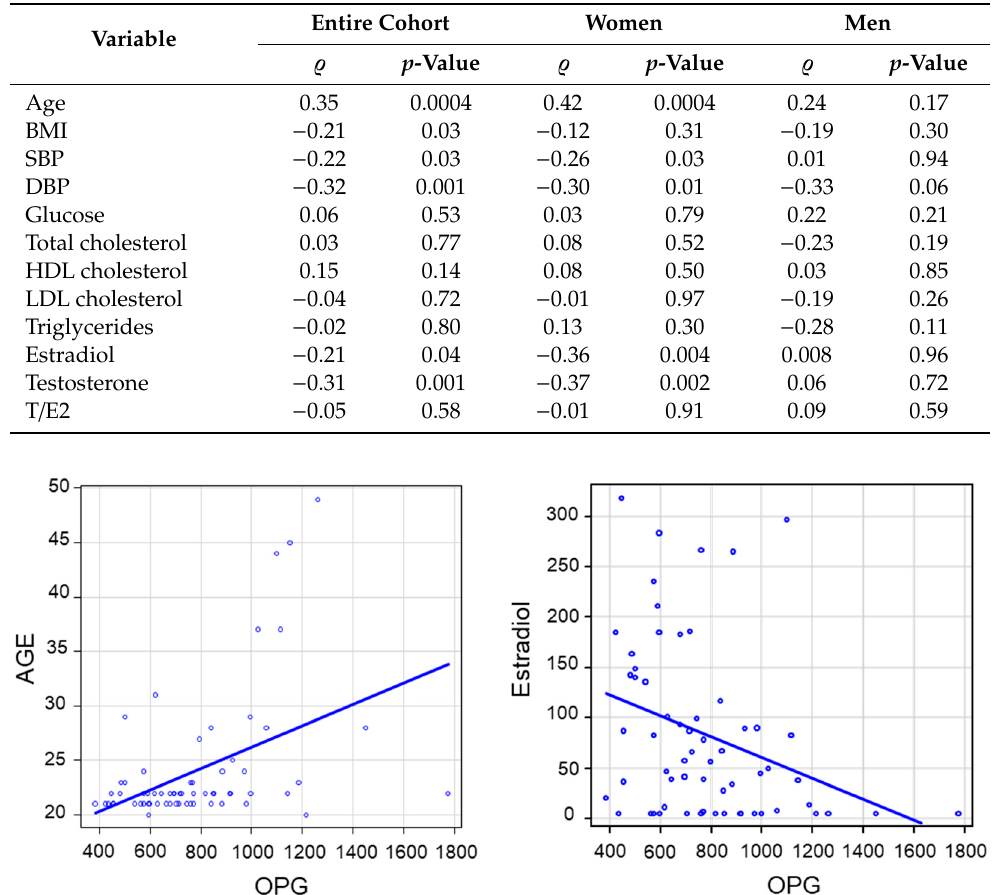
Table 4. Correlation between OPG and clinical / hormonal variables in the entire cohort and the subgroups of women and men.